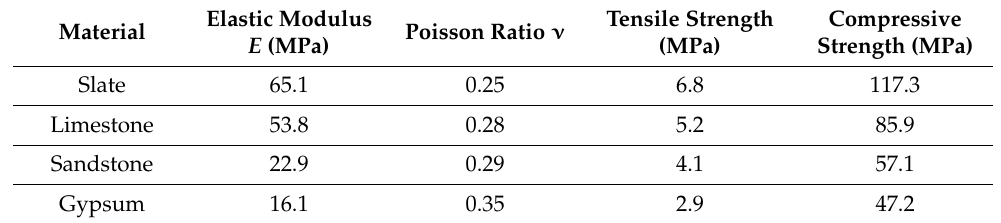
Table 1. Properties of high-strength gypsum and natural materials.